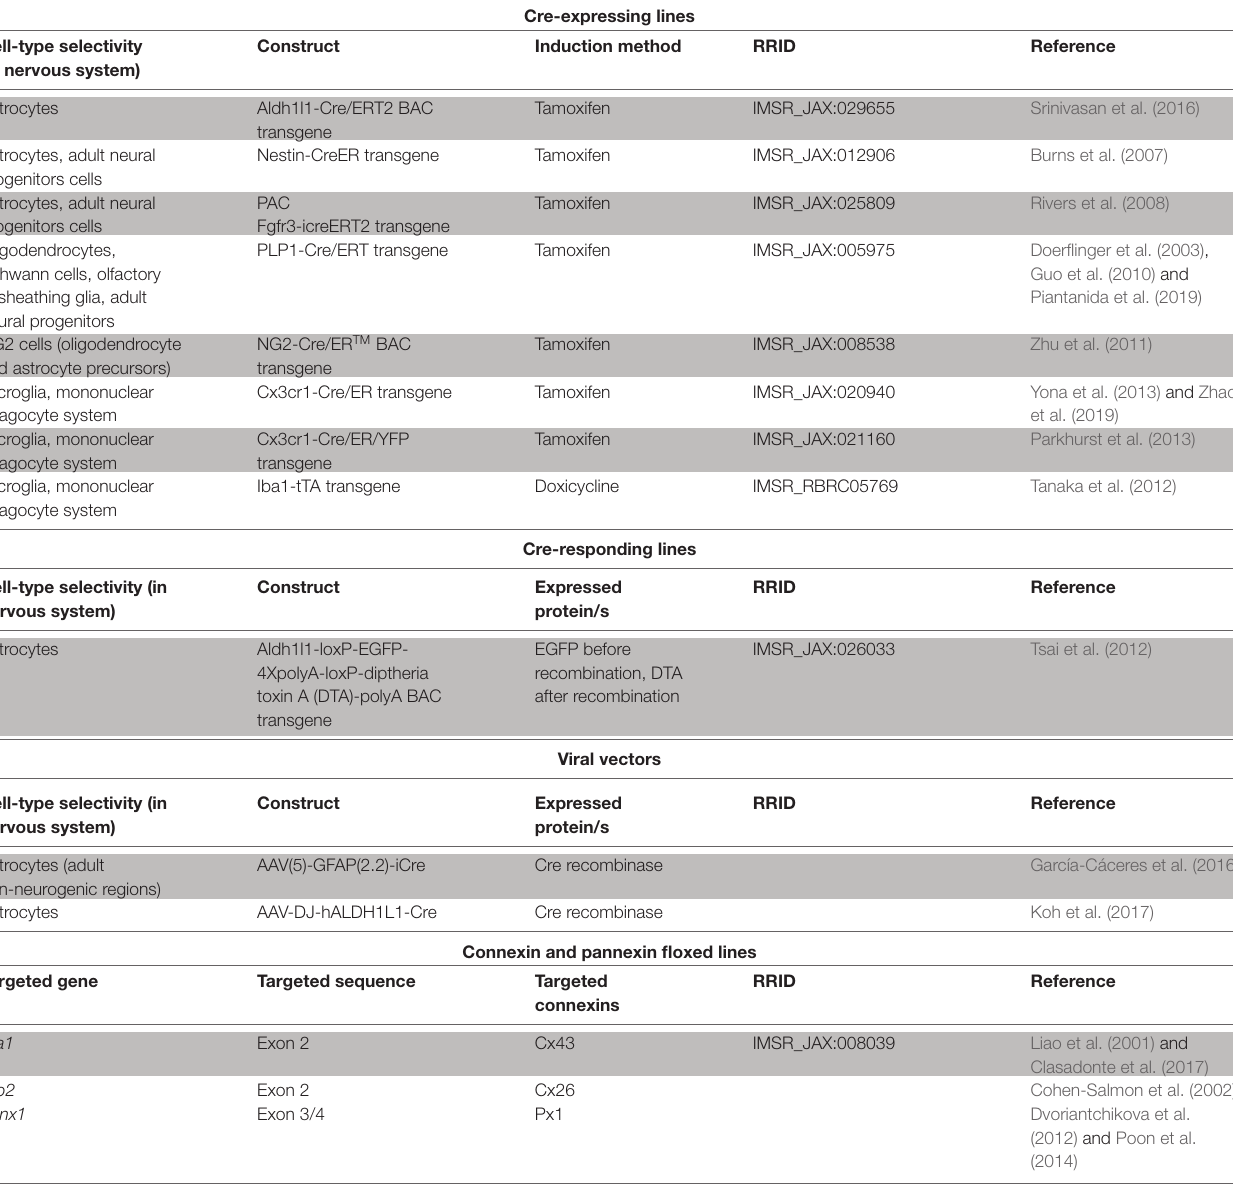
TABLE 2 | Genetic tools of potential application to achieve inducible connexin and pannexin manipulations of glial cells in vivo . Cre-expressing